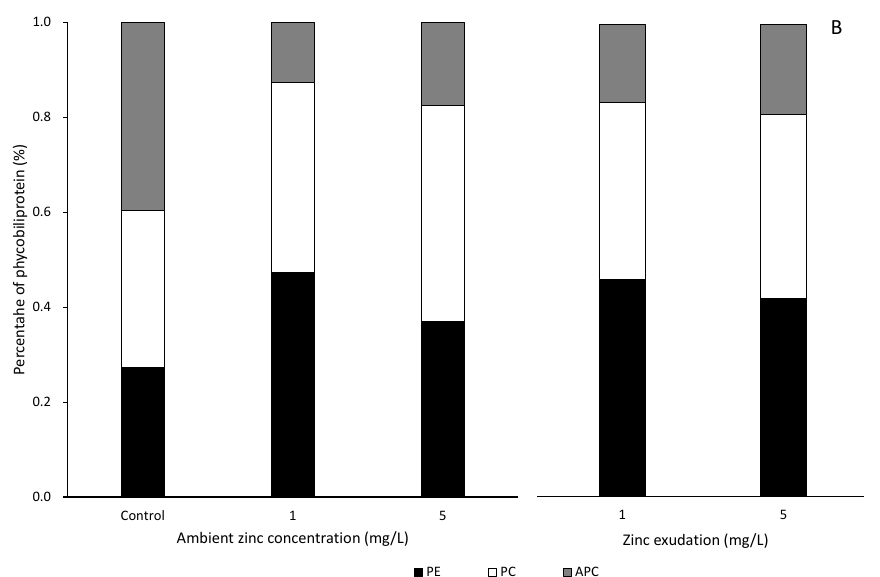
Figure 6. Proportional percentages of PE, PC, and APC to phycobiliproteins in S. suiae exposed to 0 (control), 1, and 5 Pb 2+ mg/L at 5th day of exposure and 5th day of exudation ( A ). Proportional percentages of PE, PC, and APC to phycobiliproteins in S. suiae exposed to 0 (control), 1, and 5 Zn 2+ mg/L at 5th day of exposure and 5th day of exudation ( B ).